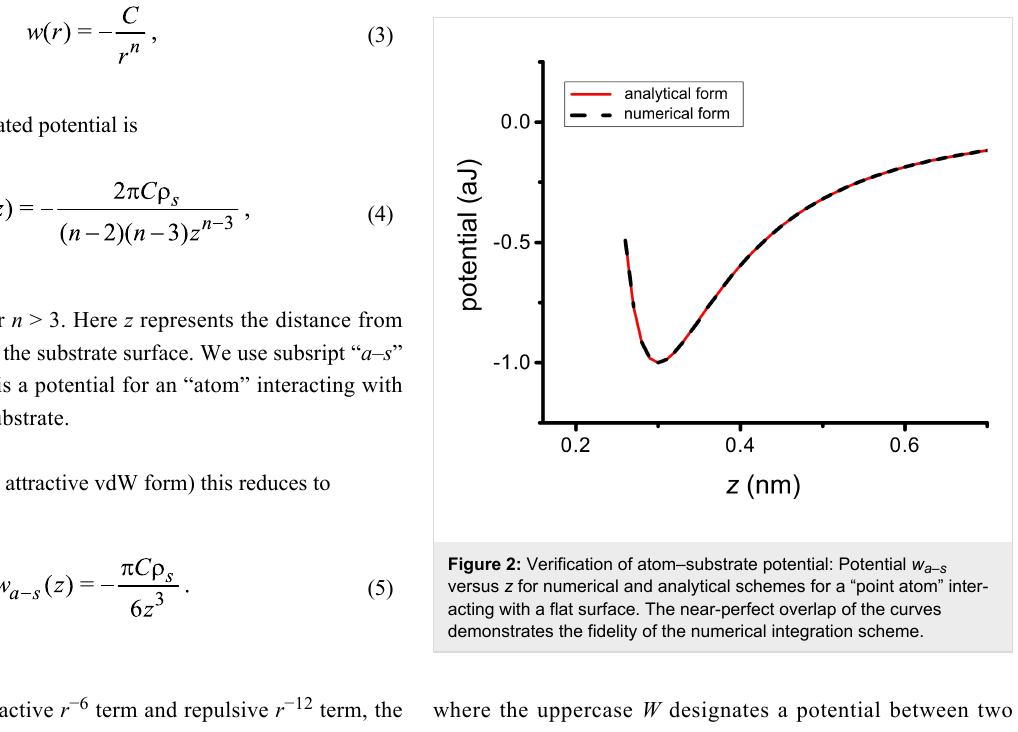
where the uppercase W designates a potential between two extended objects. Here, ρ t is the tip density (number/volume) and the integration is over the (spherical) tip volume. The z co- ordinate for W t – s ( z ) is the distance between the surface and the apex of the spherical tip (the point closest to surface), as depicted in Figure 3. Employing the NIntegrate function in Mathematica 8.0, the numerical integration of Equation 2 gener- ates the atom–surface potential as a tabulated function of z , with scaling determined by ( w 0 , h 0 ). We then numerically integrate this tabulated function over the spherical tip volume, for varying tip–surface distance z , using an approach that incorpo- rates the IDL routines INTERPOLATE and INT_3D. As a check on this numerical integration, we compare against the exact analytical result for a sphere attracted to a flat surface